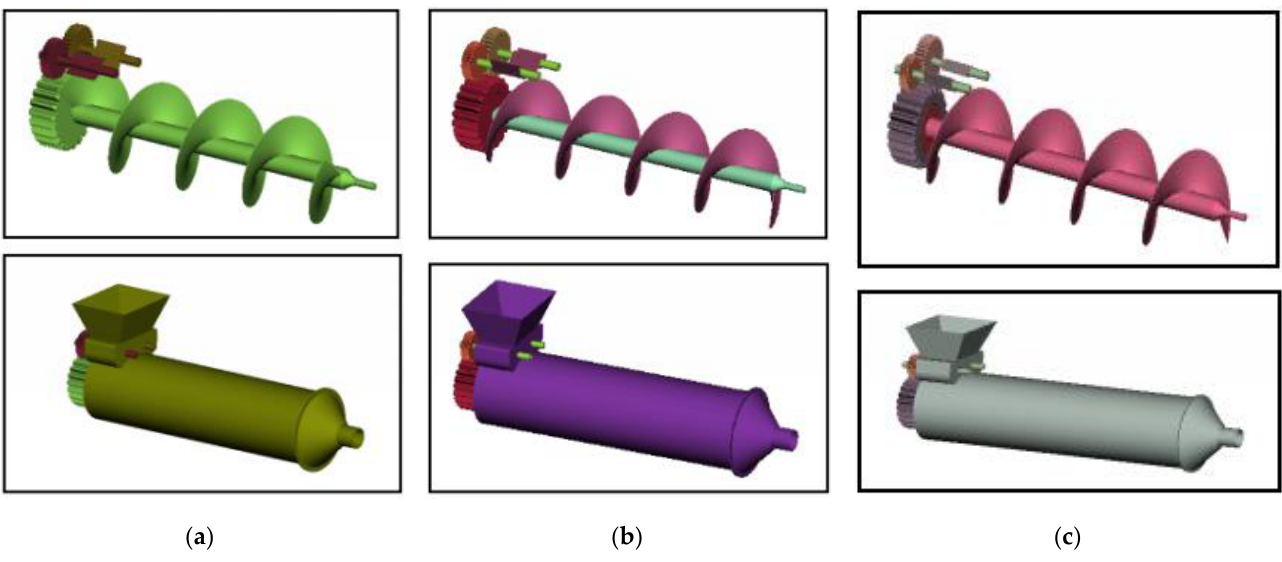
Figure 2. Three simulation models of extrusion-forming parts with different parameters: ( a ) D 1 ; ( b ) D 2 ; ( c ) D 3. ( b ) D 2 ; ( c ) D 3